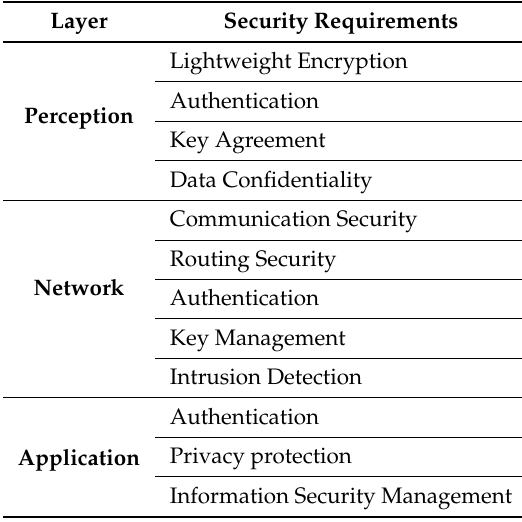
Table 1. IoT Architecture and security